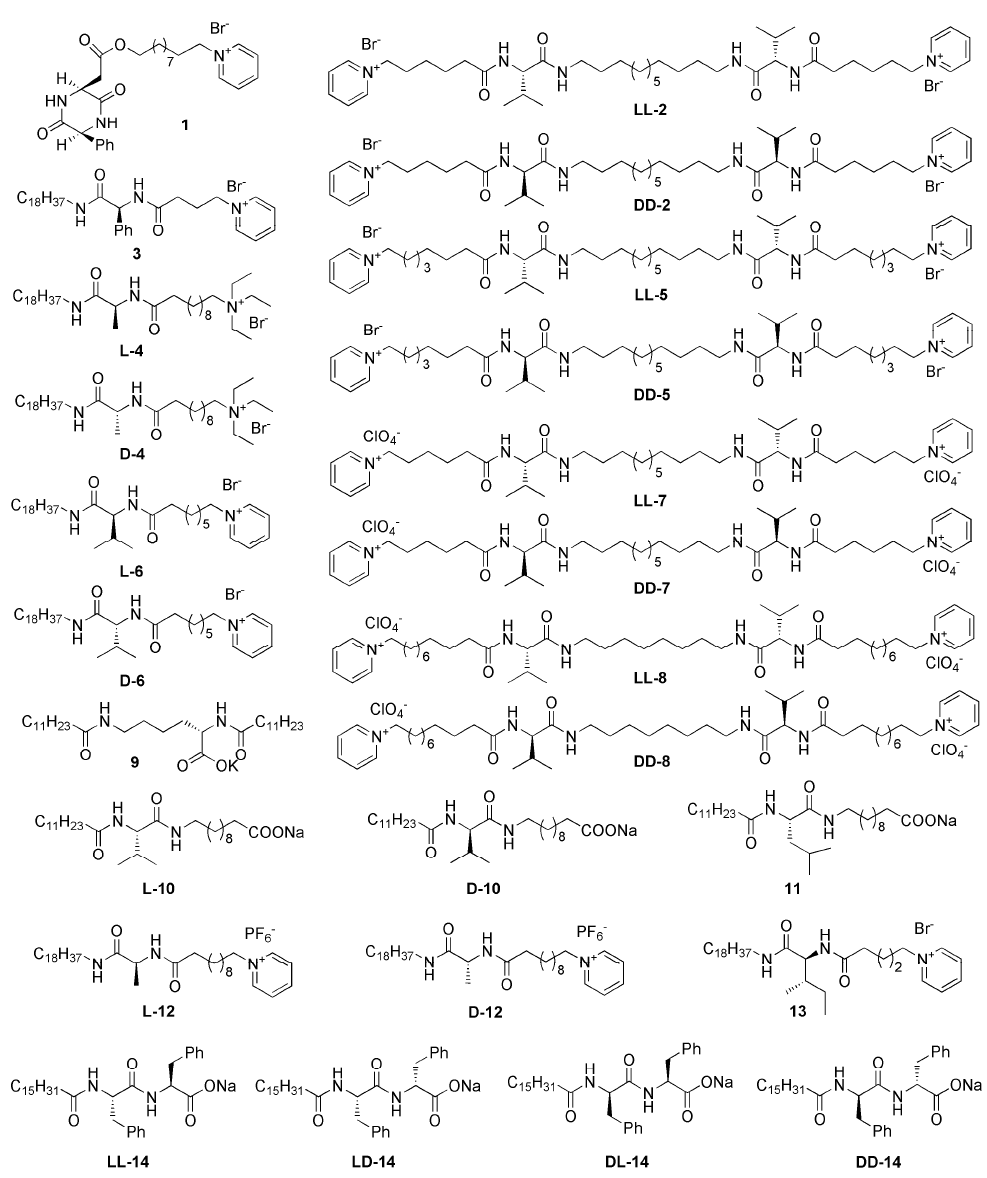
Figure 1. Molecular structures of the low-molecular-weight gelators (LMWGs).